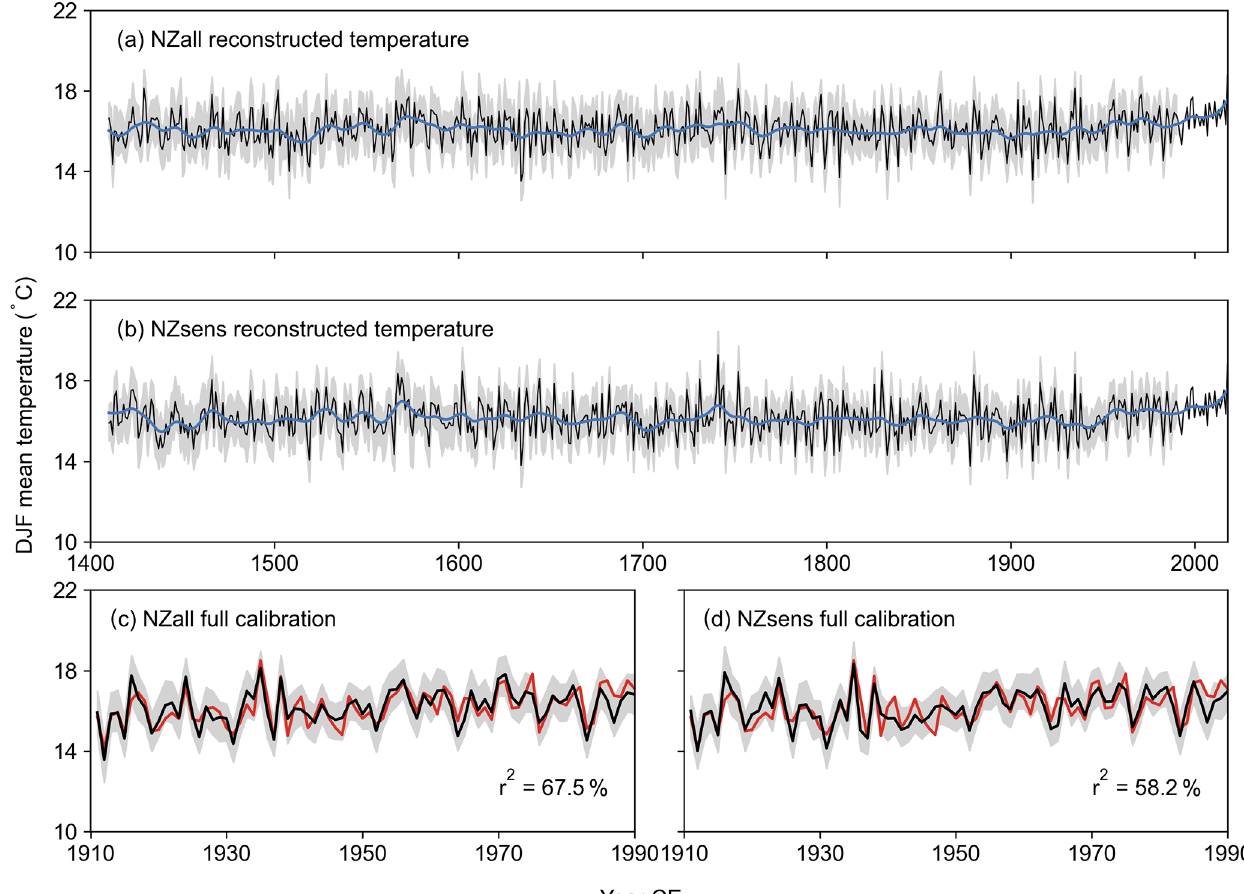
Figure 5. New Zealand average DJF temperature reconstructions. Unfiltered (black) and filtered (20-year spline; blue) mean DJF recon- struction with 90% uncertainty interval (grey) between 1400 and 2018CE for (a) NZall and (b) NZsens. Reconstruction fit to instrumental temperature (red) over the full calibration period 1911–1990CE for (c) NZall and (d) NZsens. The 90% uncertainty interval was calculated from 300 maximum entropy bootstrap